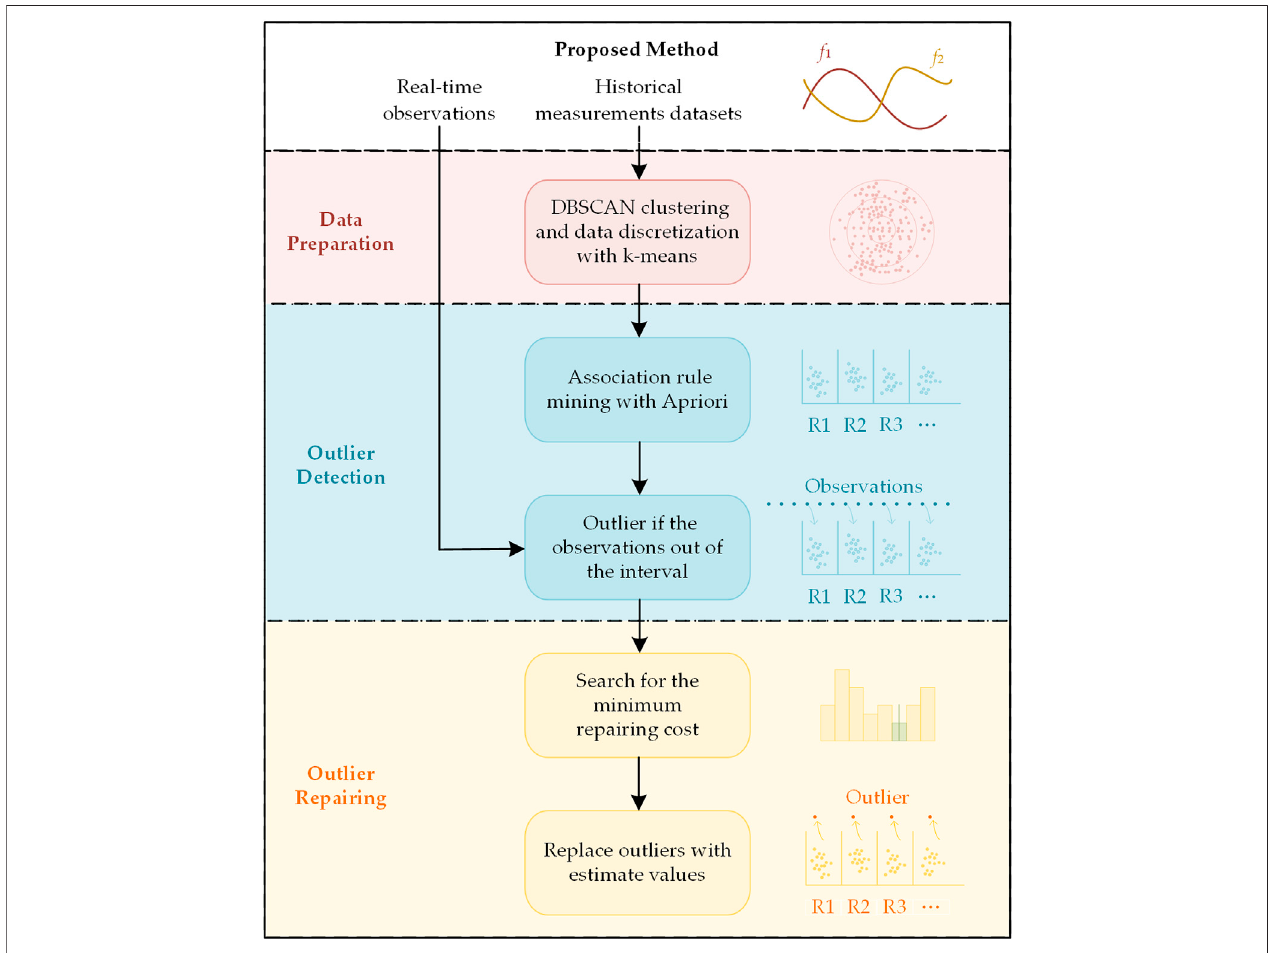
FIGURE 6 | The schema of the proposed